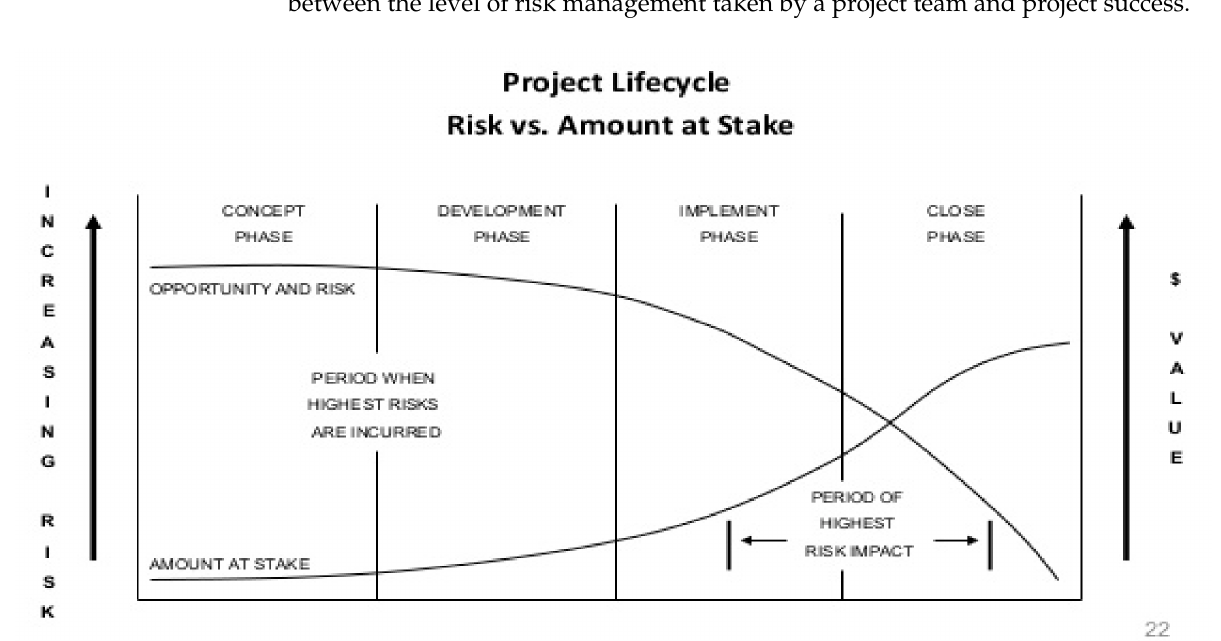
Figure 1. Correlations between the level of risks associated with a project and the amount at stake (Reference: Petrova et al.